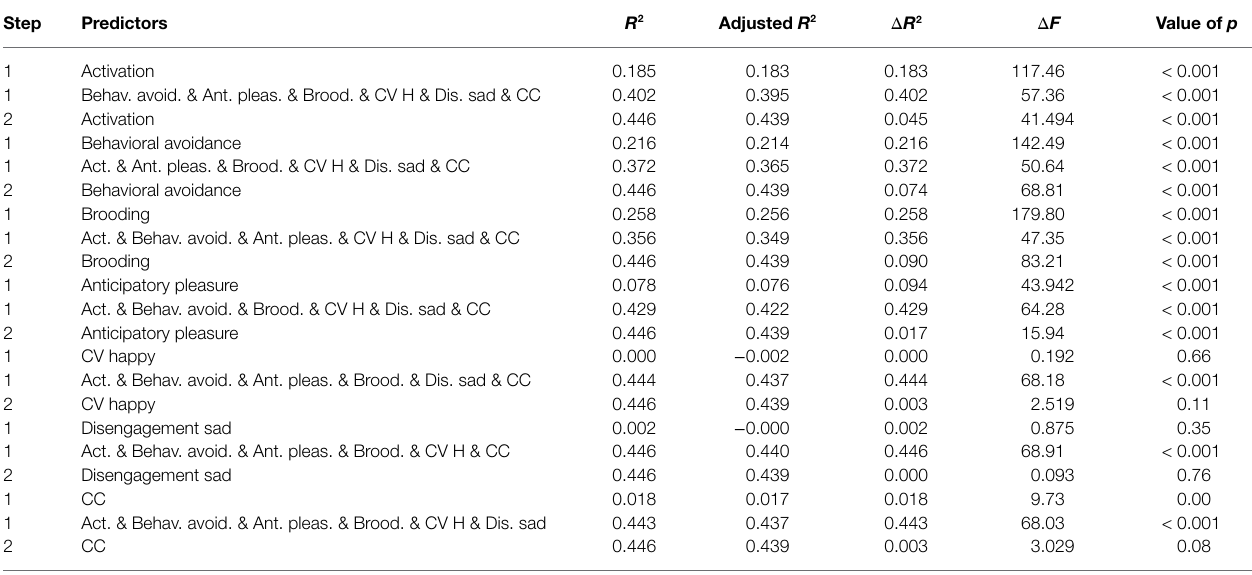
TABLE 4 | Hierarchical linear regressions of depressive